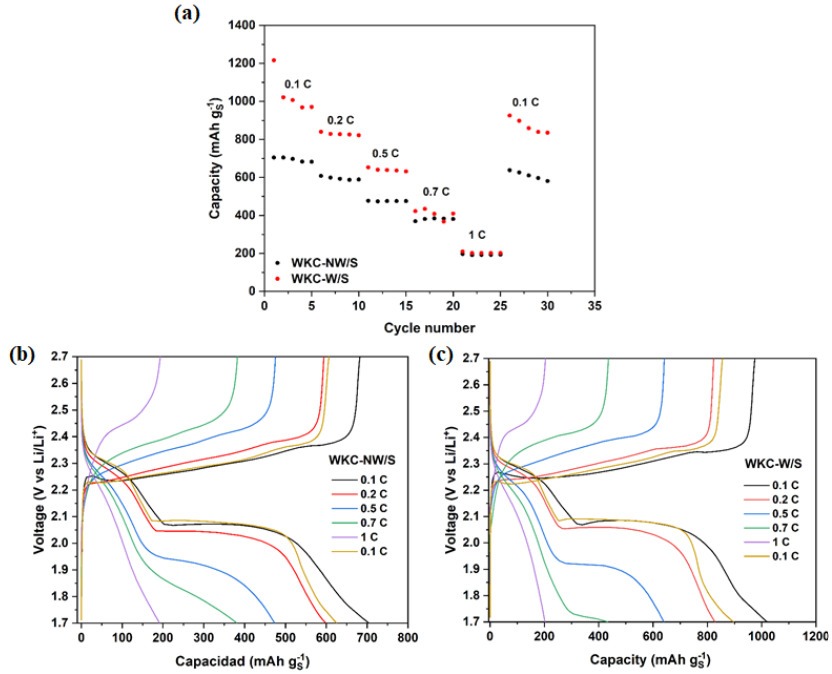
Figure 8. Rate capability analysis for WKC-NW/S and WKC-W/S ( a ), GDC profiles for the second cycle at different C-rates for WKC-NW/S ( b ) and WKC-W/S ( c ). The galvanostatic discharge/charge profiles of WKC-NW/S and WKC-W/S cathodes at 0.1 C for the 20th and 100th cycles for different mass loading (0.8 – 2.5 mg S cm −2 ) are